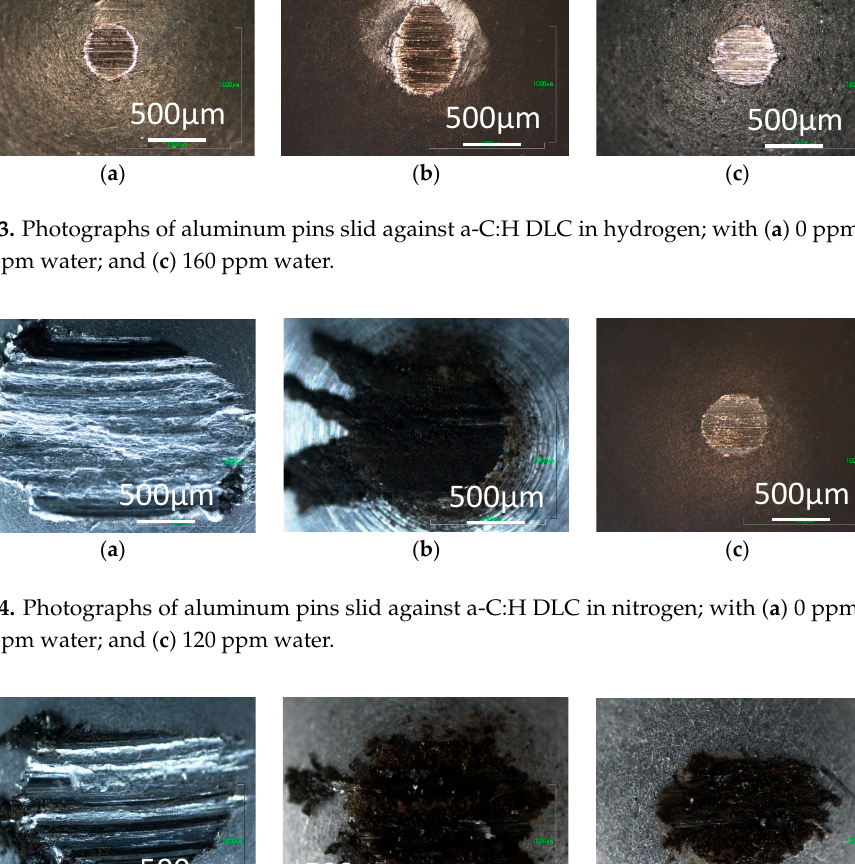
Figure 5. Photographs of aluminum pins slid against a-C:H DLC in argon; with ( a ) 1 ppm water; ( b ) 60 ppm water; and ( c ) 120 ppm water.